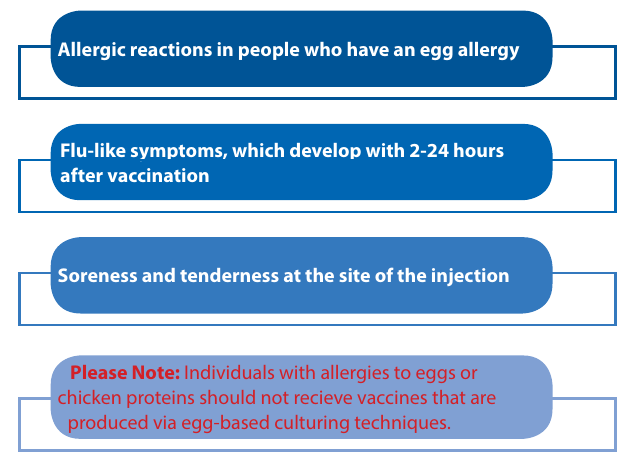
Table 3: List of individuals who would require the flu vaccine as a matter of priority 1 . Individuals that require the vaccine as a matter of priority Pregnant women, and women who are planning to fall pregnant during winter Patients younger than 18 years of age on chronic aspirin therapy HIV infected patients (CD4 cell count >100 cells/uL).